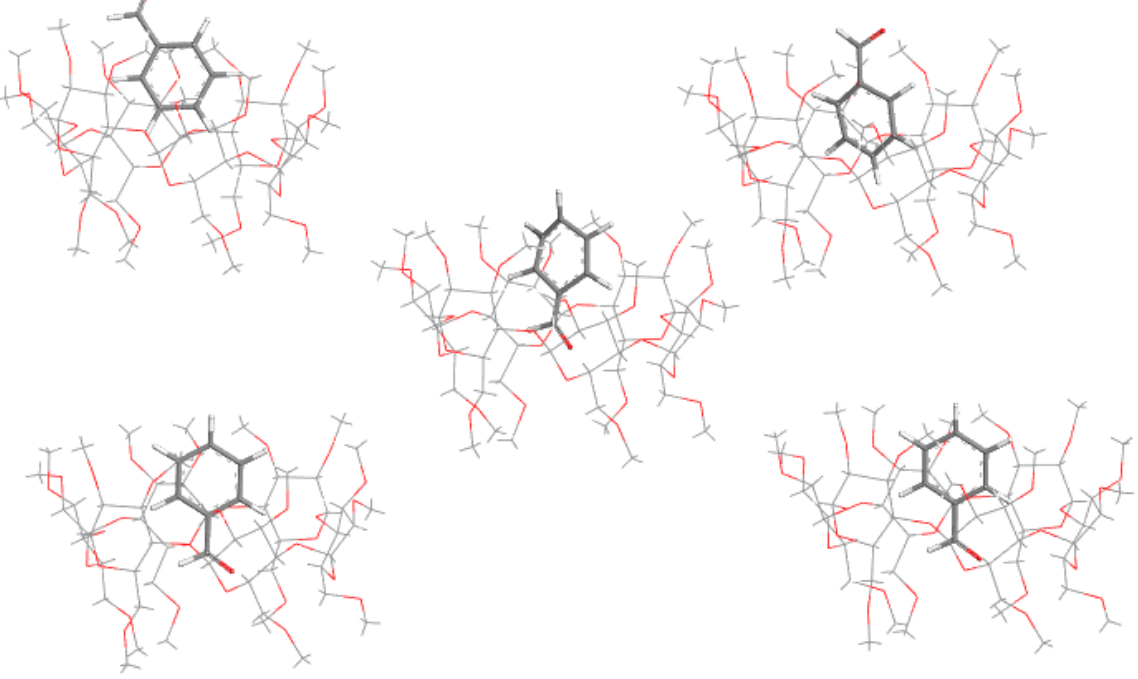
Figure 3. Comparison between the structures of the α CD complex with benzaldehyde. Top left: the best pose from molecular docking; top right: the best pose from molecular docking after optimization using DFT; bottom left: one of the poses obtained from molecular docking; bottom right: “bottom left” structure after optimization using DFT; middle one: experimental structure (CSDC ref. code: BOHWUQ). It should be noted that while the top left structure has energy lower than the bottom left by 3.4 kcal/mol, the top right structure has energy higher than the bottom right by 4.2 kcal/mol. Source: author’s archive.